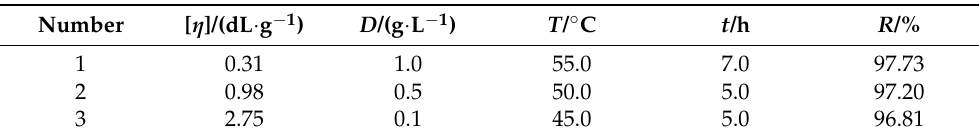
Table 8. Summary of better demulsification process conditions of poly (DMDAAC- co -DAMBAC) (9:1) copolymers with different intrinsic viscosities.